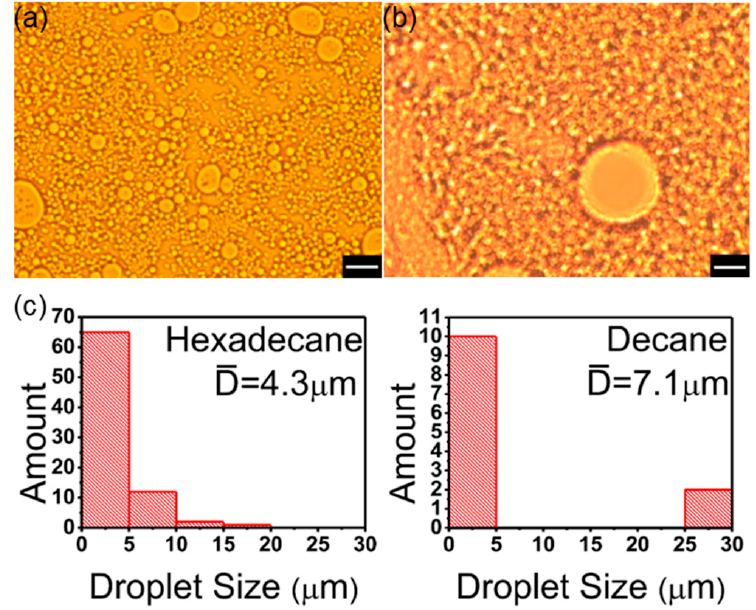
Figure 6. Microscope images of Pickering emulsion stabilized by PS@PSS with different oil phase ( a ) hexadecane; ( b ) decane. The magnification is 500 times. The bar is 10 μ m. ( c ) Droplets size distribution in number corresponding to microscope images.